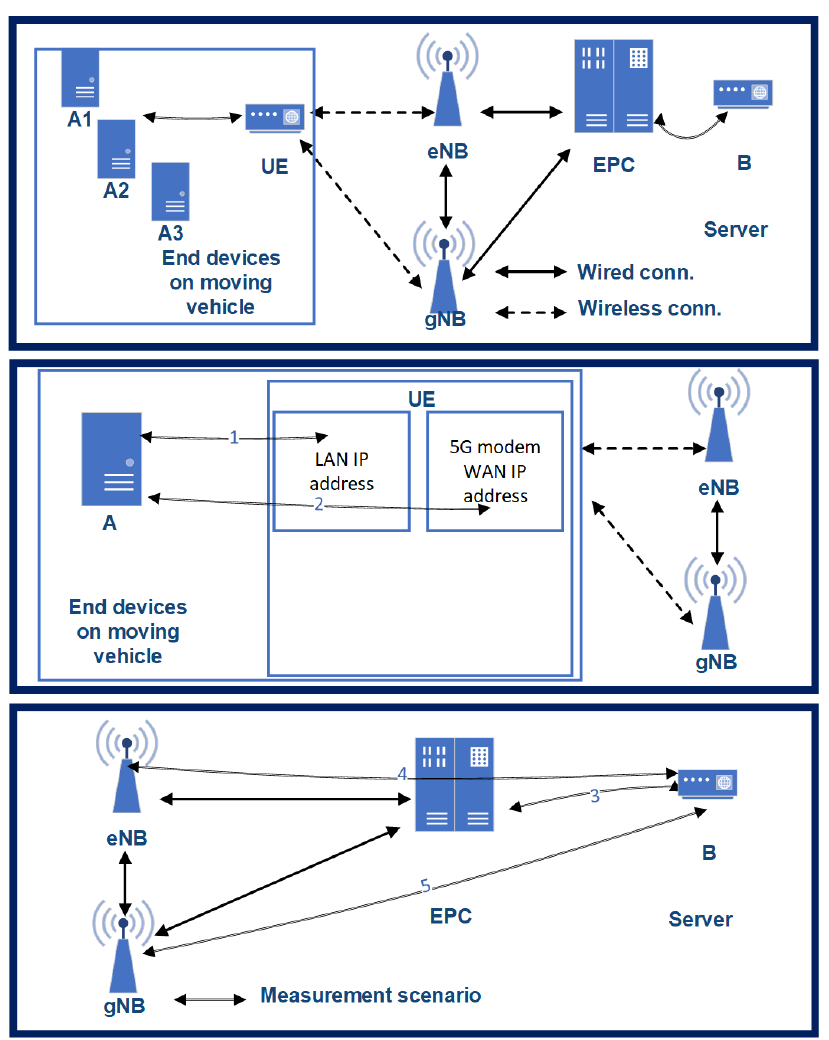
Figure 9. The architecture of our 5G testbed on the vehicle—as Option